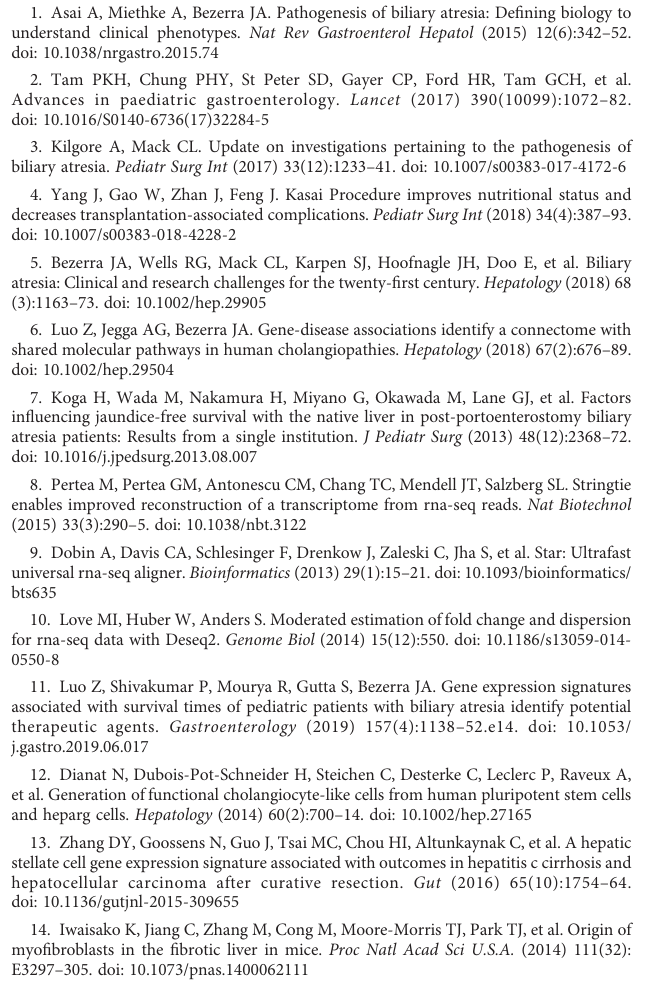
SUPPLEMENTARY FIGURE 5 Identi fi cation of signature genes for BA molecular subtypes. Signature genes for each molecular subtype (A) . The expression of signature genes in the training cohort (B) . The ROC results of signature gene line model in the training dataset (C) . The ROC results of signature gene line model in the validation dataset (D) . The ROC results of signature gene line model in our center dataset (E)